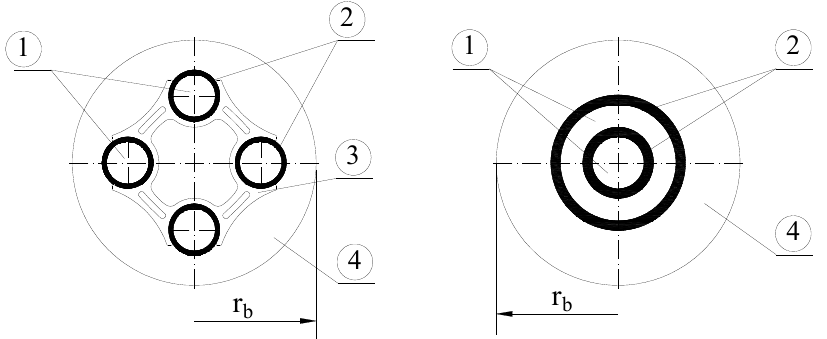
Figure 7. Design aspects of vertical borehole configuration as part of a cross-section of the double U pipe and coaxial pipe (1—working fluid, 2—pipe, 3—spacer, 4—grouting material, r b —borehole radius).